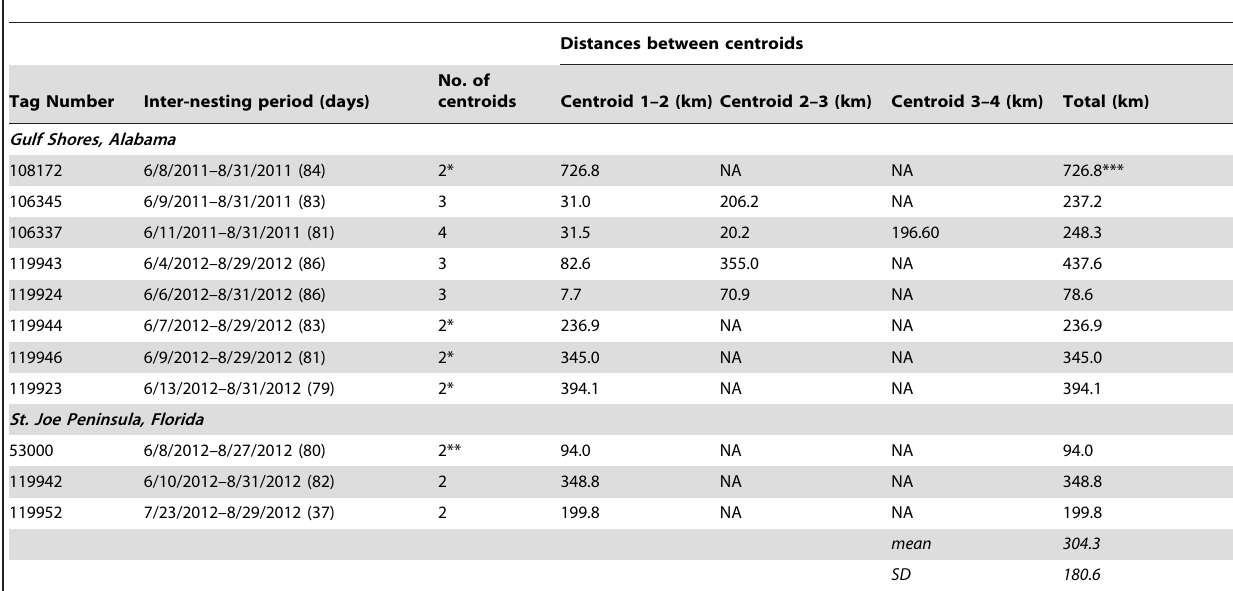
Table 3. Distances between successive minimum convex polygon (MCP) and kernel density estimate (KDE) centroids for loggerhead turtles ( Caretta caretta